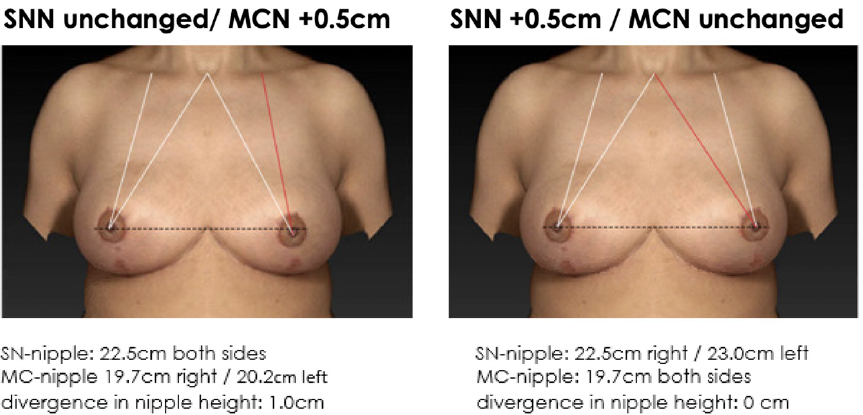
Figure 5. Non-symmetrical mirrored computer-simulated breast models with a modified MC-to- nipple distance and an SSN-to-nipple distance of +0.5 cm. In total, 56% of the plastic surgeons and 60% of the patients find the image with unaltered MC-to-nipple distance more attractive than the image with the unaltered SSN-to-nipple distance.